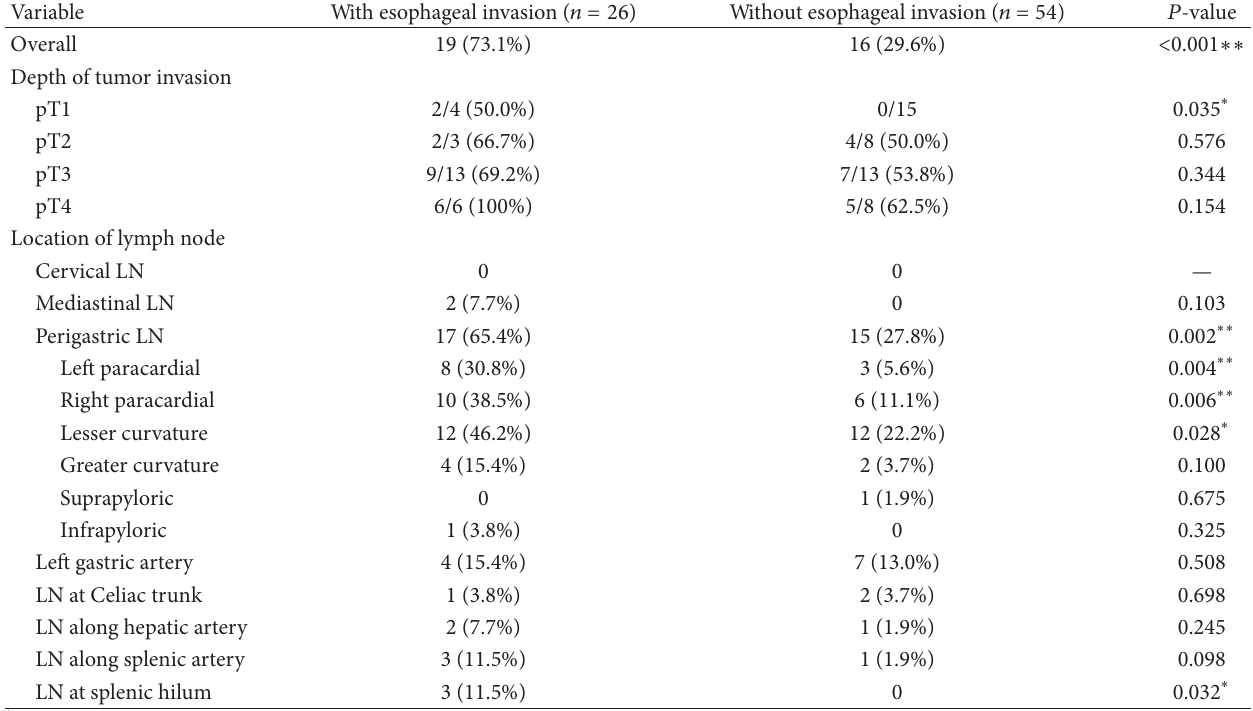
T 3: Comparison of lymph node metastasis in patients with gastric cardia cancer, with or without esophageal